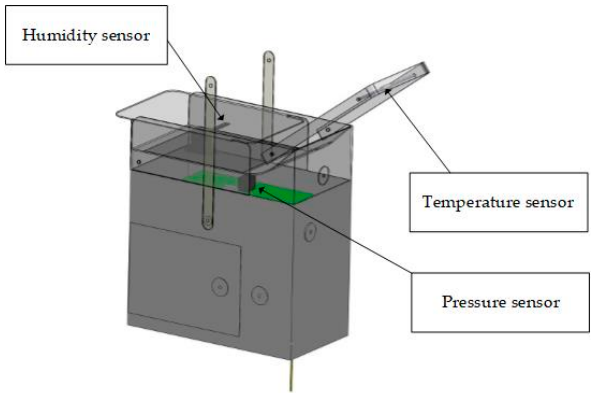
Figure 1. The measurement set up. Table 1. The accuracy of the sensors. T—temperature; P—pressure; RH—relative humidity. Parameter